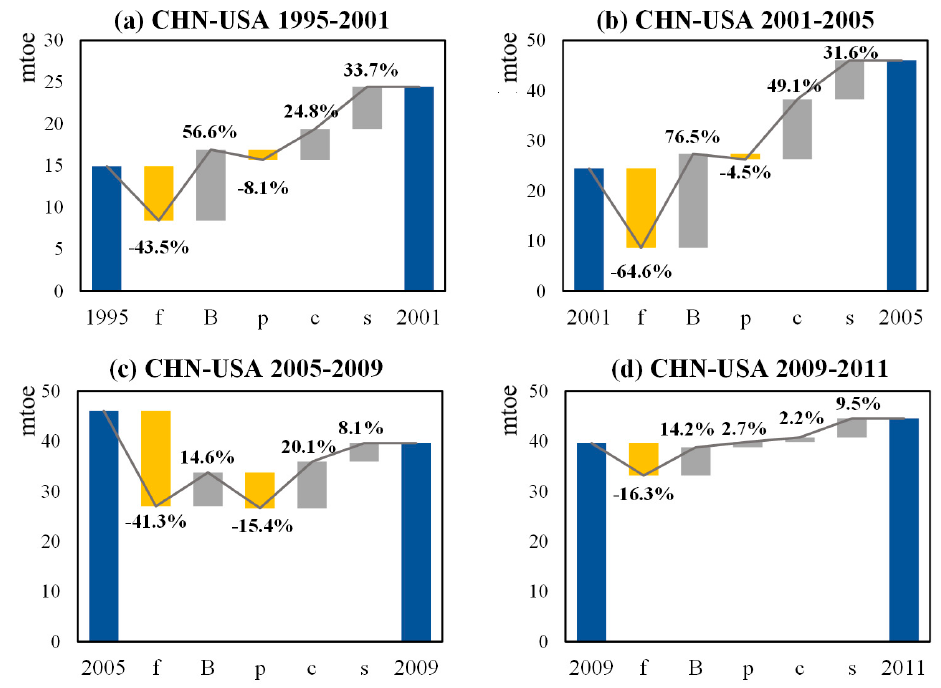
Figure 7. Decomposing results of virtual oil flows’ changes embodied in China’s exports to the US in